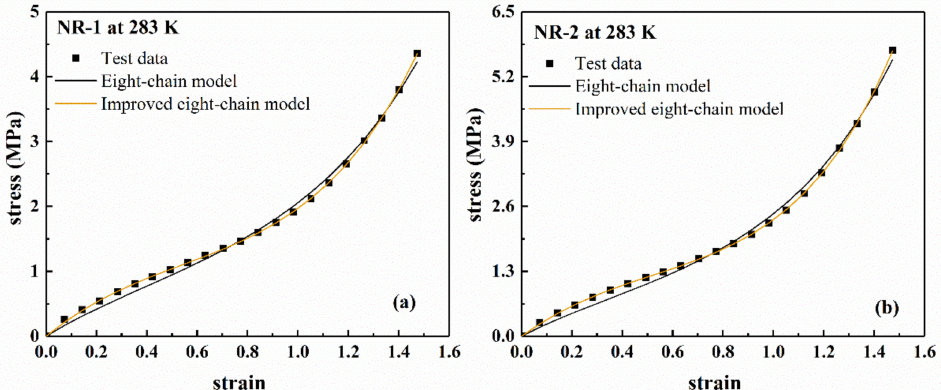
Figure 6. Fitting results of eight-chain model and improved eight-chain model for filled rubber under uniaxial tension, ( a ) NR-1; ( b ) NR-2.